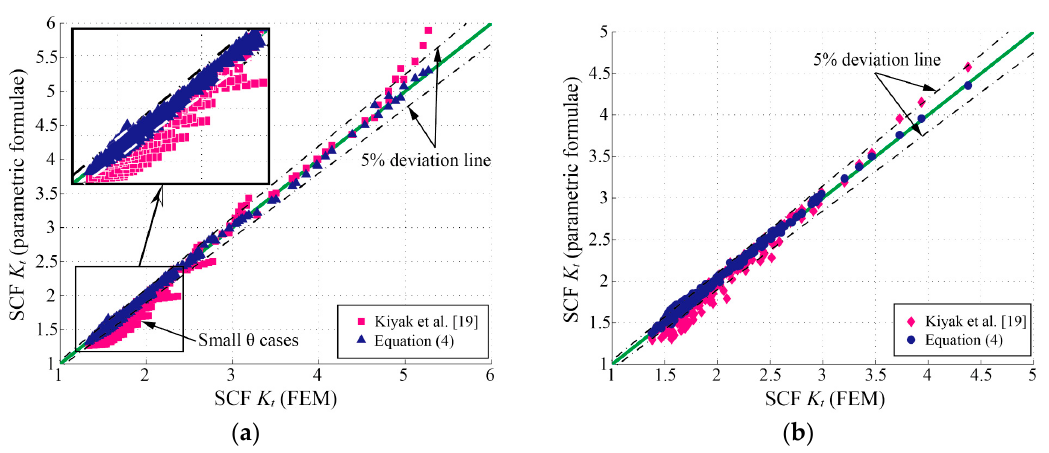
Figure 10. Comparisons of the SCF ( K t ) determined by FEM and parametric formulae: ( a ) training data system; ( b ) test data system.